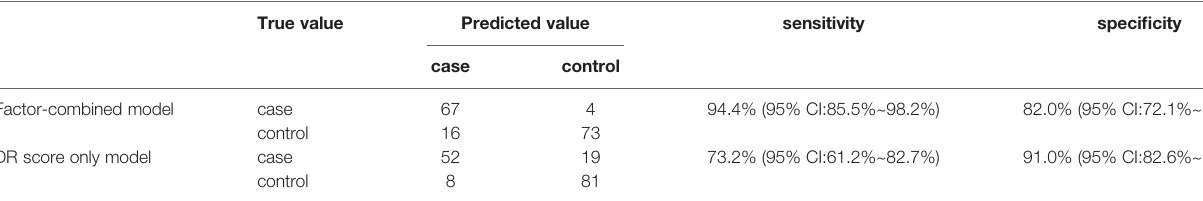
TABLE 3 | The classi fi cation results of the train sets for screening DR.